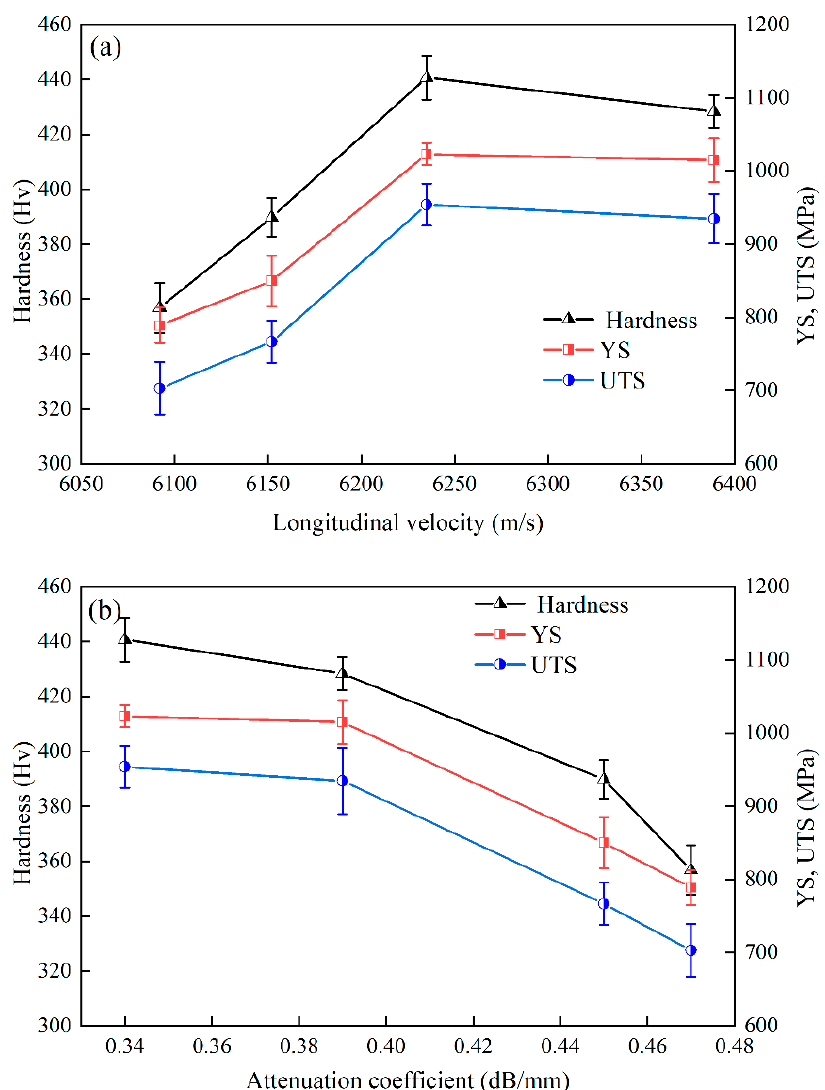
Figure 7. ( a ) Correlation between ultrasonic longitudinal velocity and mechanical properties; ( b ) correlation between attenuation coefficient and mechanical properties.